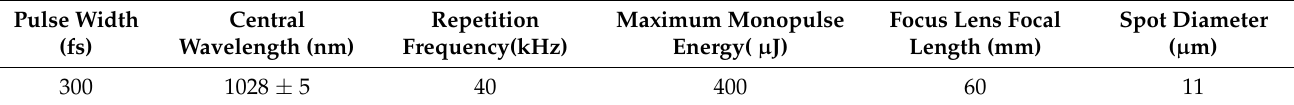
Table 3. Main parameters of femtosecond